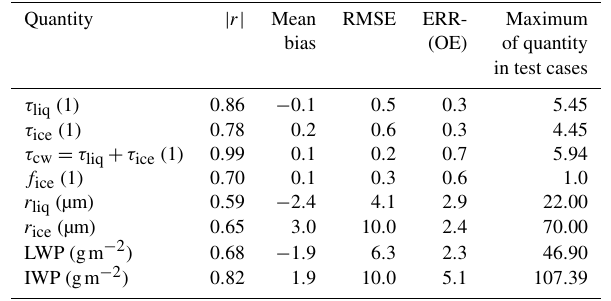
Table 3. Results of the test case retrievals. | r | is the correlation co- efficient of each quantity. Mean bias is the mean difference between the retrieval and the true size of the parameter. RMSE is the root- mean-square error of the difference between the retrieval and true parameter. For τ liq , ice and r liq , ice , ERR(OE) is the standard devia- tion calculated from the posterior covariance matrix of the optimal estimation, stated in Eq. (5). For the other quantities, ERR(OE) is calculated by error propagation. Maximum of quantity in test cases specifies the maximum value that can be used for this quantity in the test cases. A total number of 253 test cases are included in these calculations.